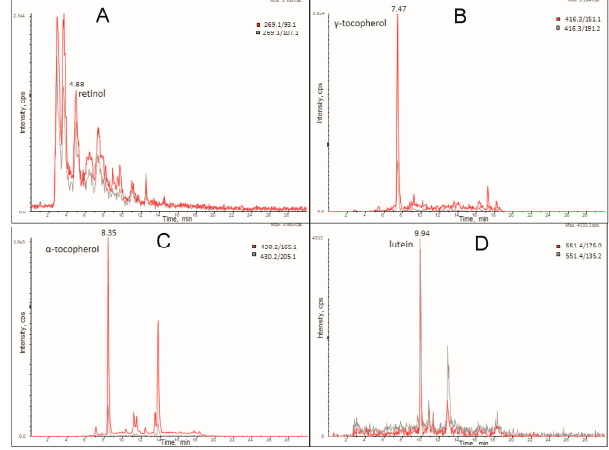
Figure 5. LC-MRM profile of retinol ( A ), gamma-tocopherol ( B ), alpha tocopherol ( C ) and lutein ( D ) extracted from a microalga sample by SFE. Extraction conditions: P CO2 = 35 MPa, T CO2 = 40 °C, 5% MeOH.